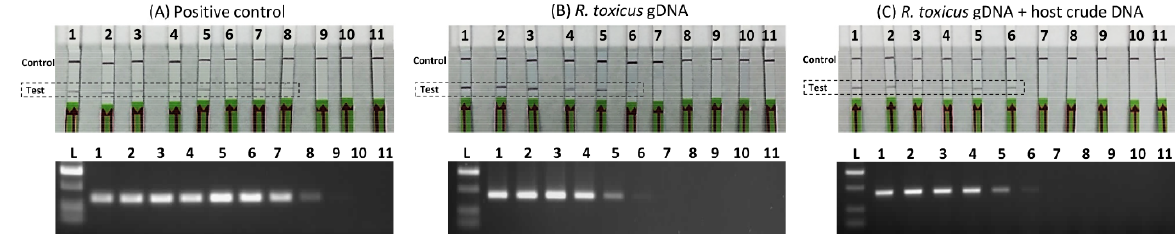
Figure 5. Sensitivity and spiked sensitivity validation of the Rathayibacter toxicus -specific recombinase polymerase amplifi- cation (RPA) assay. The RPA assay results were compared to the results of a R. toxicus -specific endpoint PCR assay. Tenfold serial dilutions (1 ng to 1 ag) were used to perform the assays; upper images are the RPA results and lower images are the endpoint PCR results. ( A ) RPA and endpoint PCR assays with tenfold dilution of positive control (plasmid DNA-carrying primers and probe target sequences); ( B ) RPA and endpoint PCR assays with tenfold serially diluted R. toxicus genomic DNA; ( C ) RPA and endpoint PCR assays with tenfold serially diluted R. toxicus genomic DNA plus 5 μ L of crude host (ryegrass) DNA.